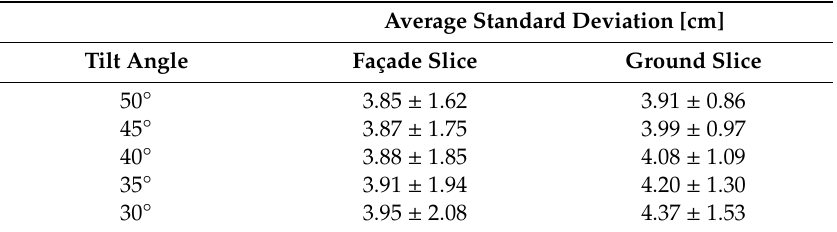
Table 3. The estimated average standard deviation on the ground and facade slices using OS-1-64.